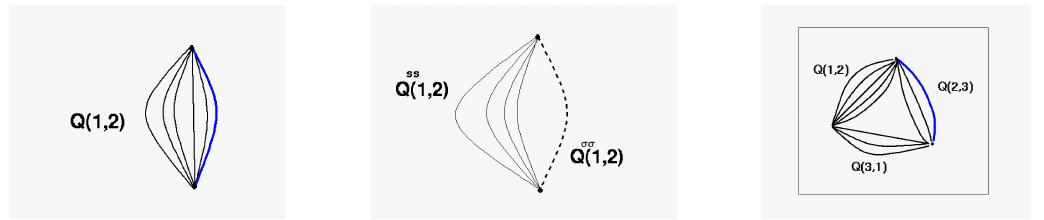
Figure 3: Three diagrams in terms of the superspace / replica order parameters. Each vertex stands for a superspace (or replica) index, each line for a Q ( a , b ) , where ( a , b ) are the labels of the ends of the